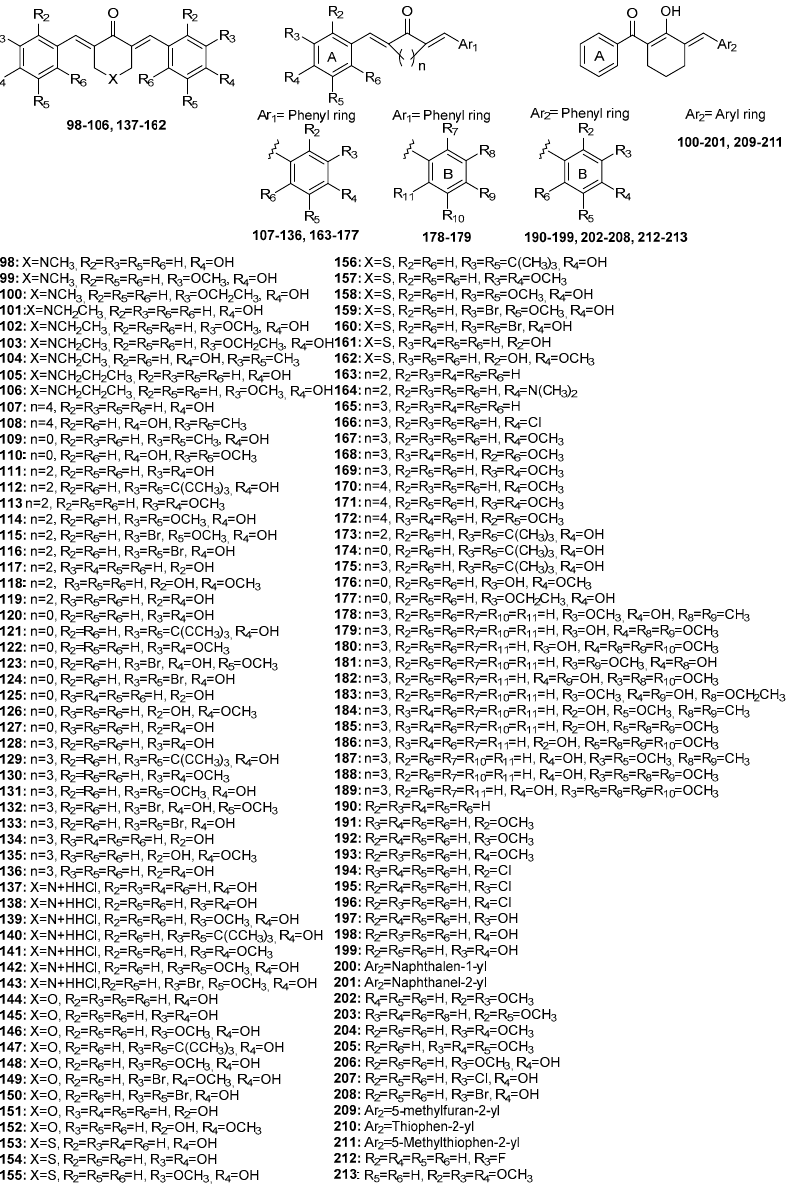
Figure 6. Diarylpentanoids as promising antioxidant agents.